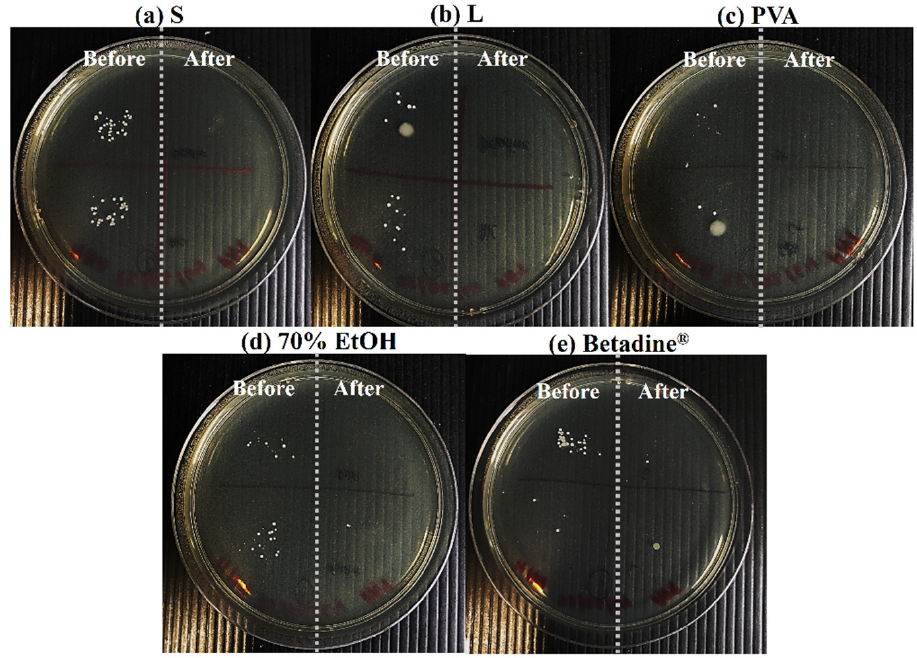
Figure 6. MHA plate with bacteria before and after the application of the